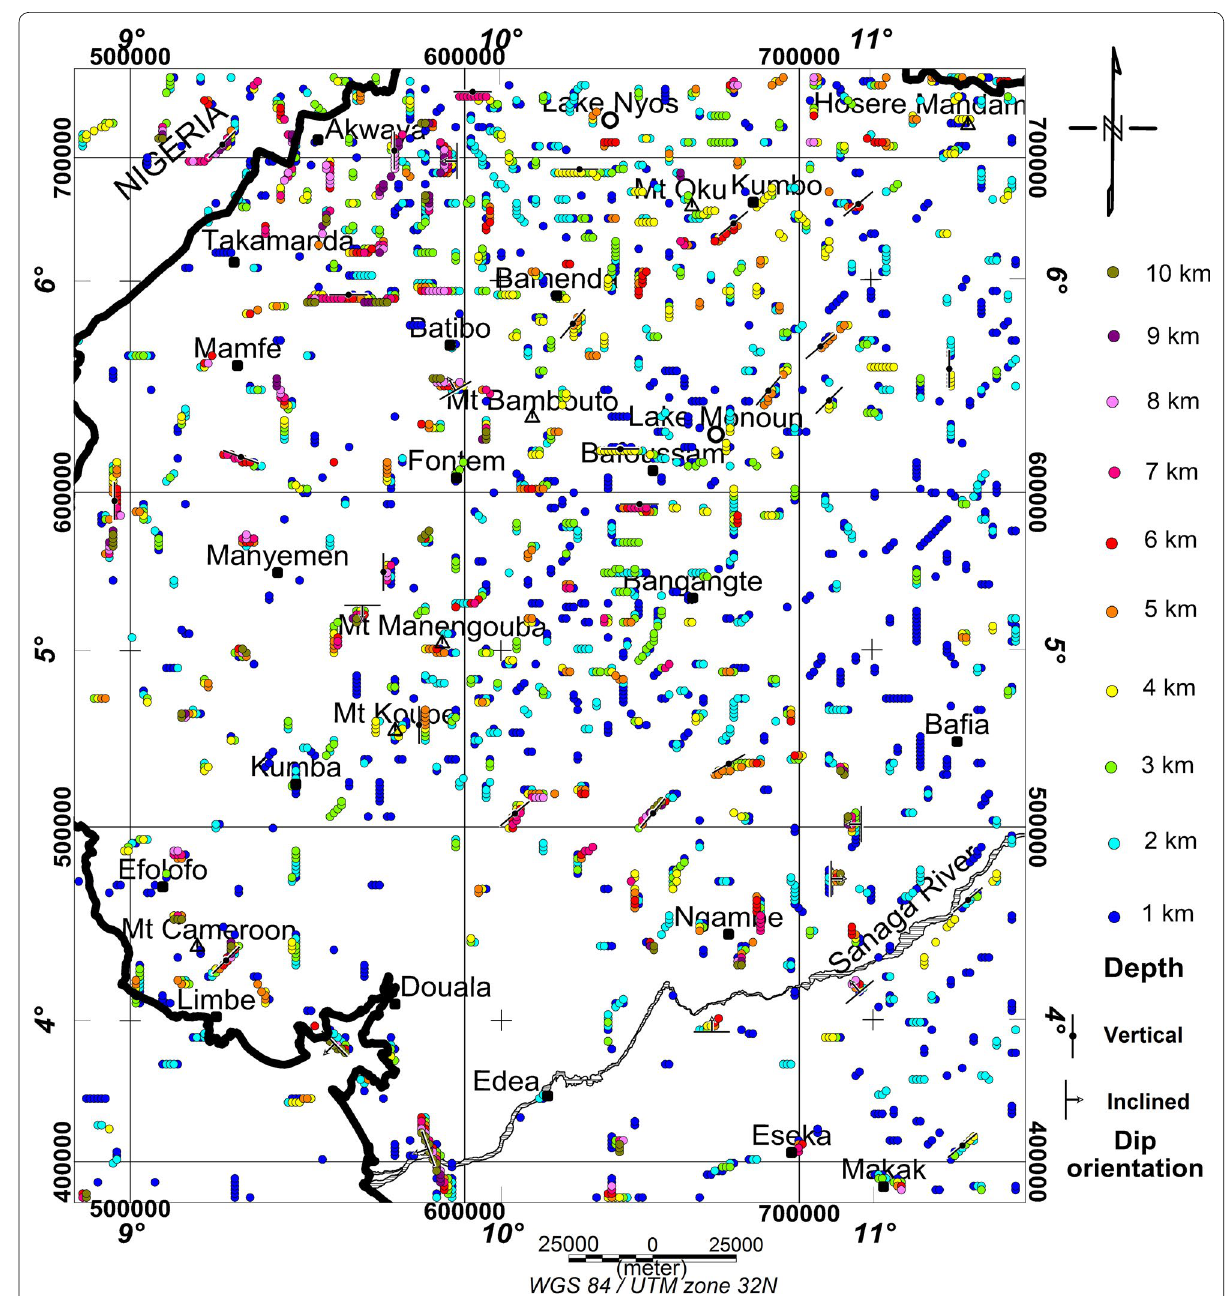
Fig. 8 Map of horizontal gradient maxima derived from upward continuation at different